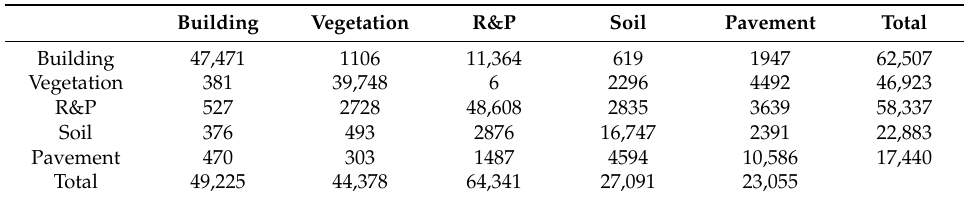
Table 4. Confusion matrix of the LiDAR data classification map, where the reference is shown as Figure 15. The values in the table indicate the numbers of pixels.